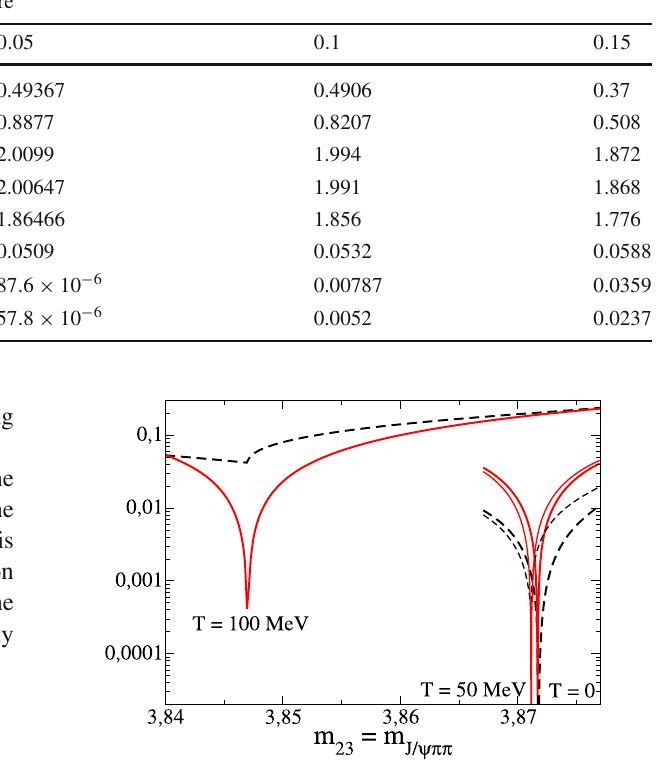
Fig. 5 Kinematic singularity conditions for the triangle (red solid line) lim (cid:5) → 0 ( q on + − q a − ) = 0,andtwo-bodythreshold(blackdashedline), lim (cid:5) → 0 ( q a + − q a − ) , as functions of m 23 = m J /ψππ invariant mass, at different temperatures